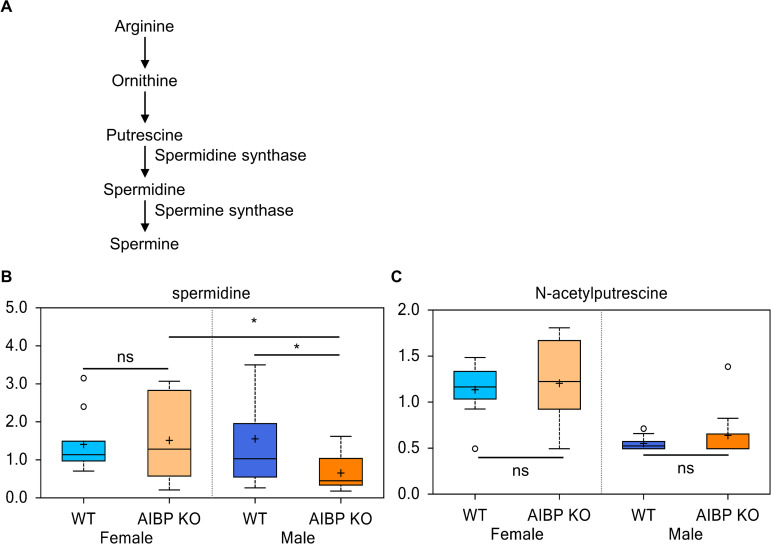
AIBP modulation of polyamine spermidine metabolism.A. Spermidine and spermine biosynthesis pathway. B. Plasma content of spermidine and its precursor derivative N-acetyl putrescine in control and AIBP knockout mice. *: p<0.05; ns: not significant (p>0.1).